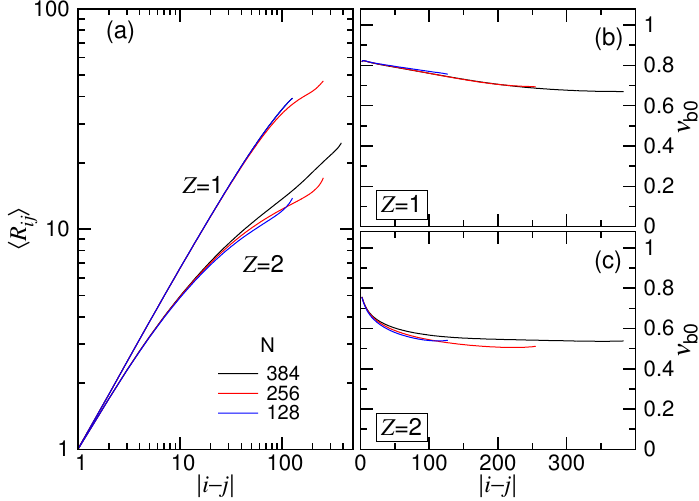
Figure 13. ( a ) Mean distance (cid:104) R ij (cid:105) of a monomer pair ( i , j ) in the Z = 1 and the Z = 2 solutions. The calculated exponent ν b0 is plotted as a function of | i − j | in ( b ) the monovalent and ( c ) the divalent